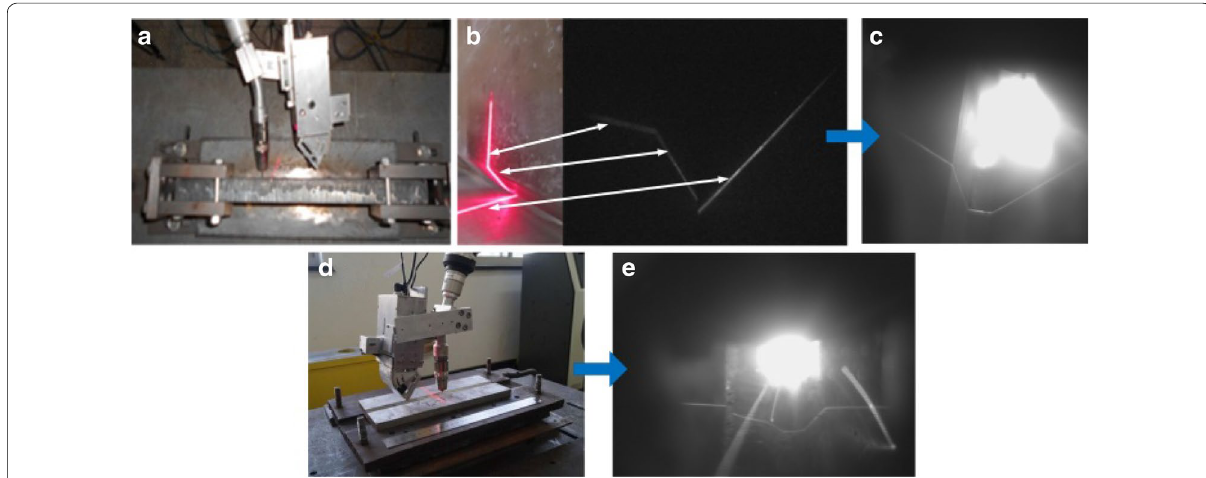
Figure 1 WSP acquisition process with T-joints and butt joints: a vision sensor based on structured-light for T-joints, b Imaging of T-joints, c typical image, d vision sensor with butt joints, e typical image with butt joints